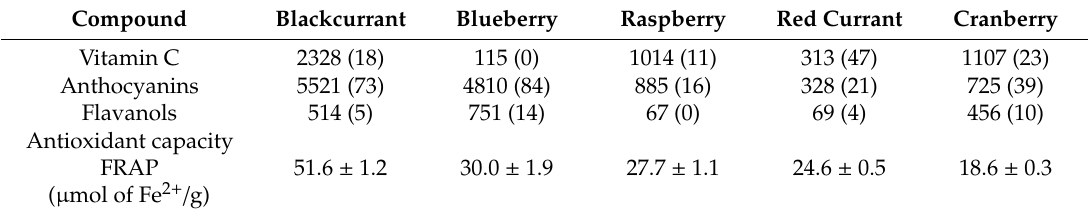
Table 2. Antioxidant capacity ( µ mol of Fe 2 + / g) and total content of vitamin C, anthocyanins, and flavonols (nmol / g of fresh weight) contributing to antioxidant capacity of blackcurrants, blueberries, raspberries, red currants, and